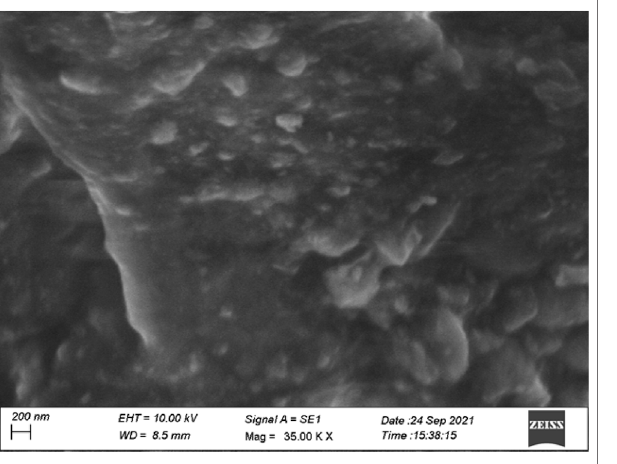
FIGURE 4 | SEM image of chitosan derivative.